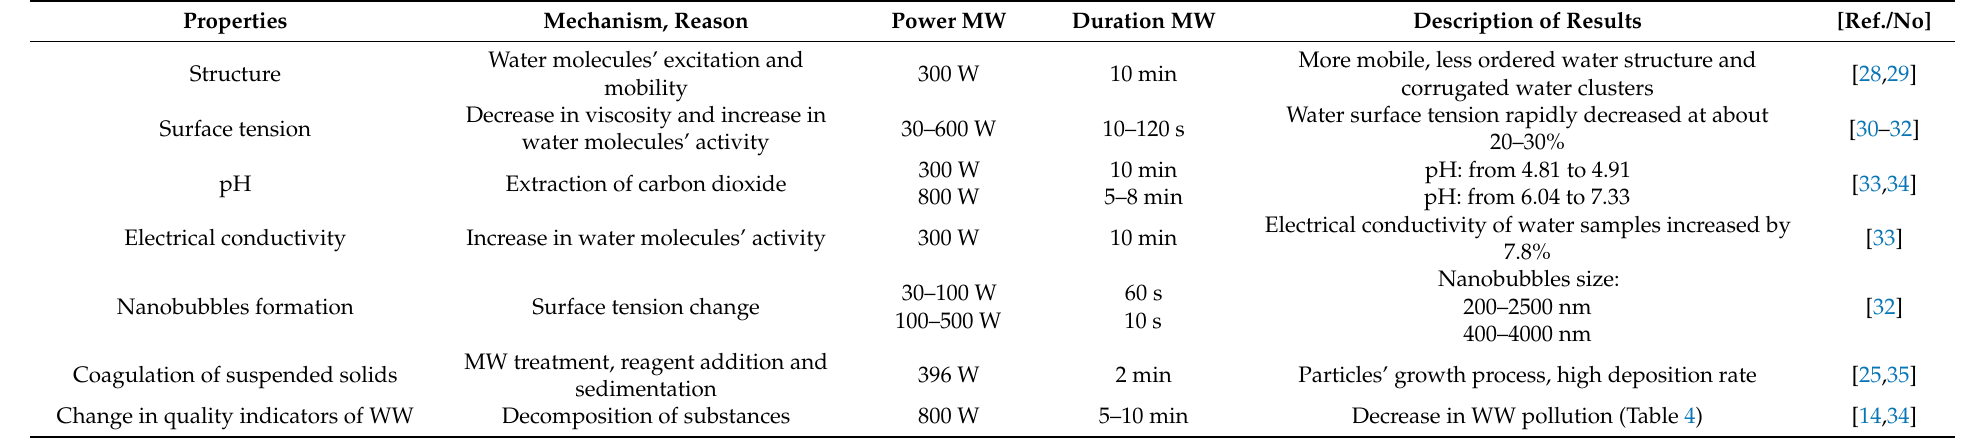
Table 3. Changes in the physical and chemical properties of water/wastewater under the influence of